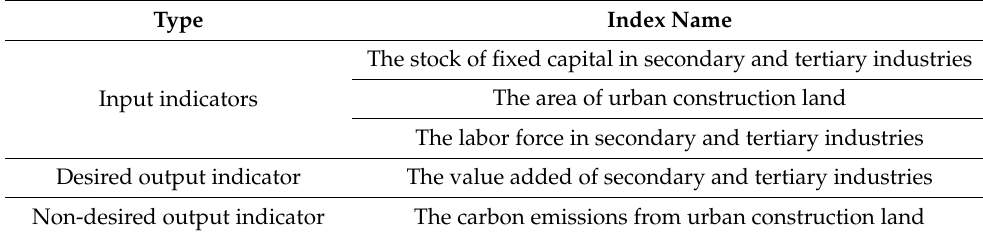
Table 2. The evaluation indicator system of